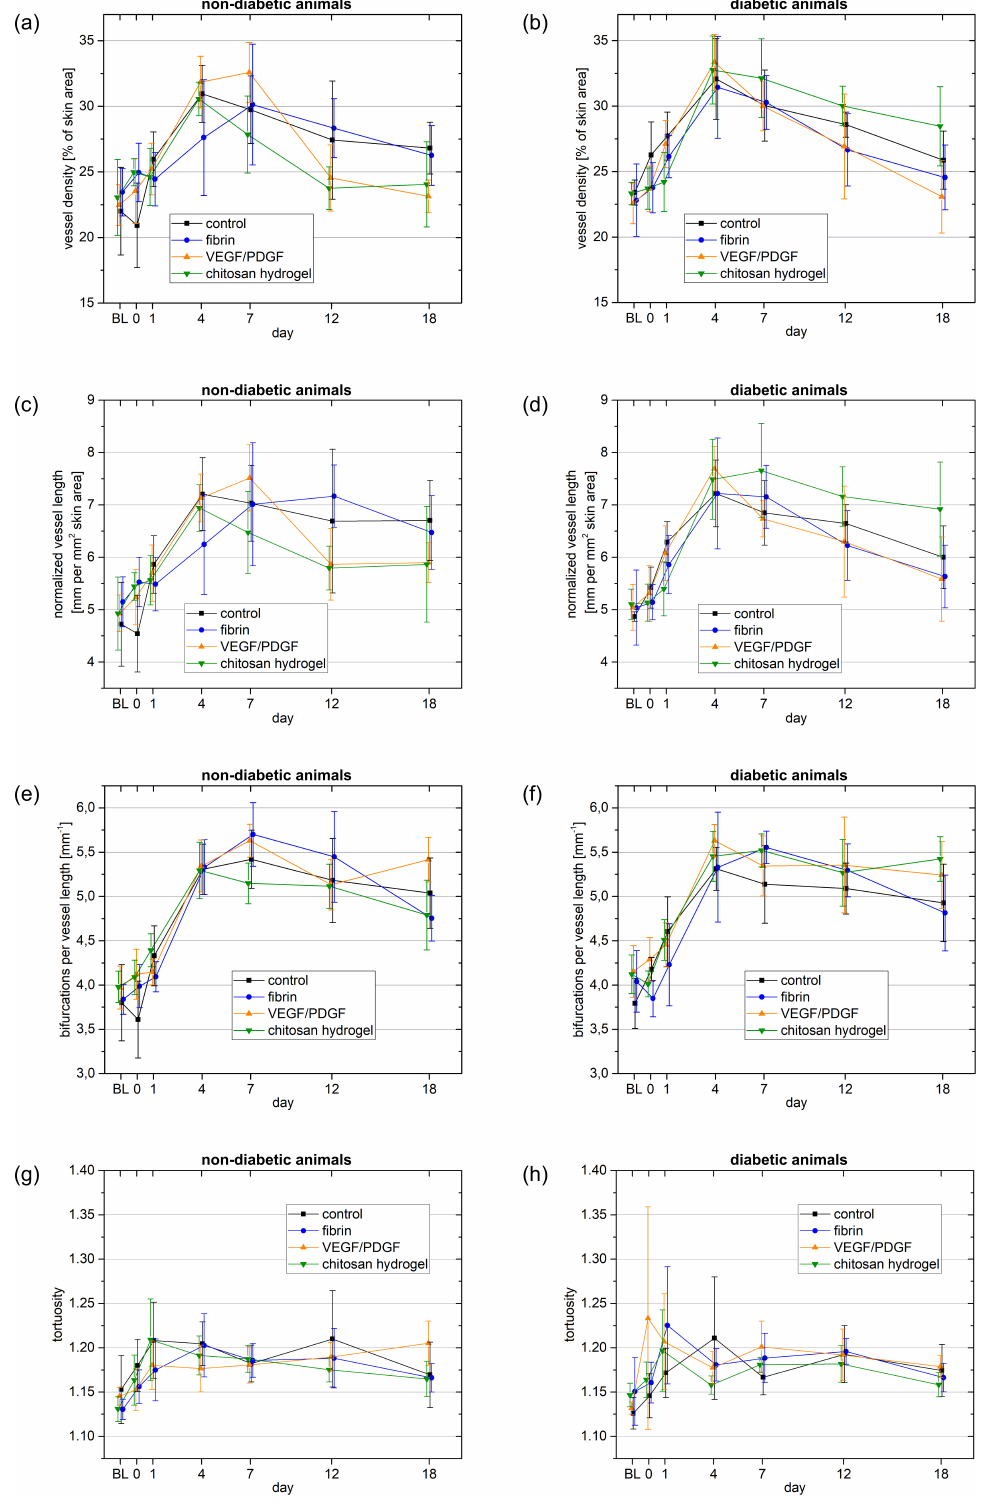
Figure 5. Vascular parameters derived from OCT angiograms in ( a , c , e , g ) non-diabetic and ( b , d , f , h ) di- abetic mice. ( a , b ) Vessel density. ( c , d ) Vessel length. ( e , f ) Number of bifurcations per vessel length. ( g , h ) Vessel tortuosity. The error bars represent the standard